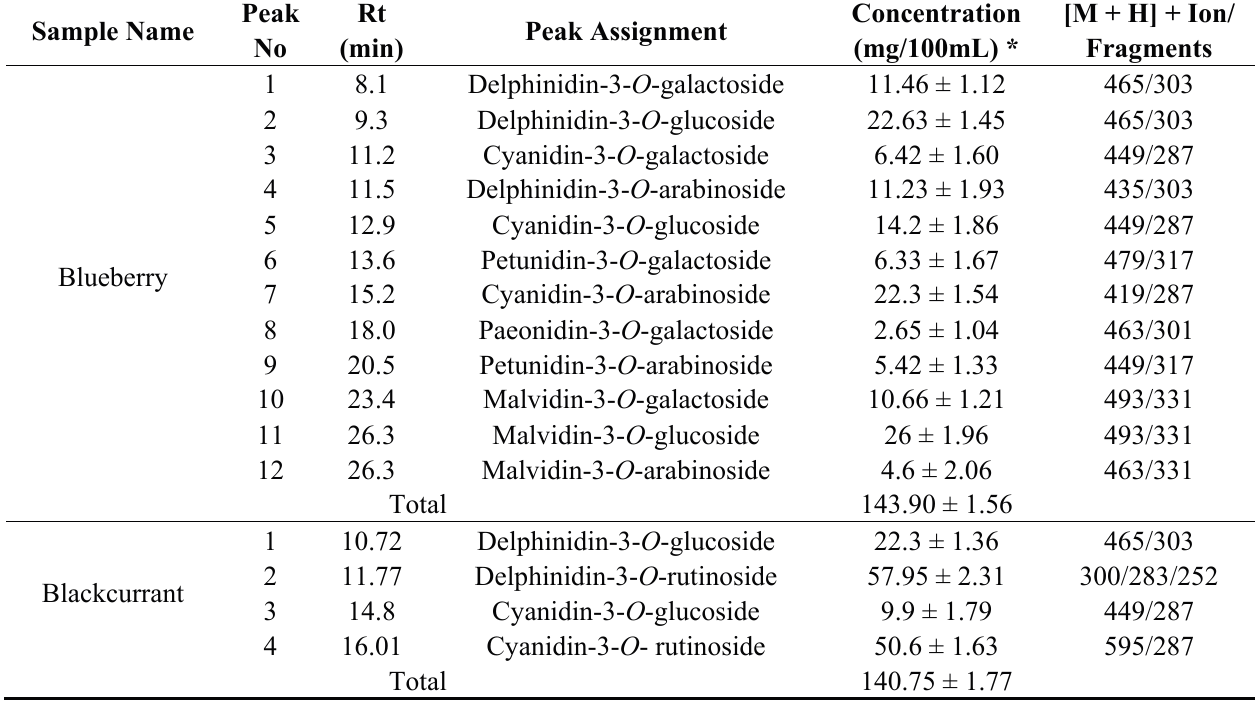
Table 1. Chromatographic characteristics and mass spectral data of anthocyanins obtained from blueberry and blackcurrant purified juices.